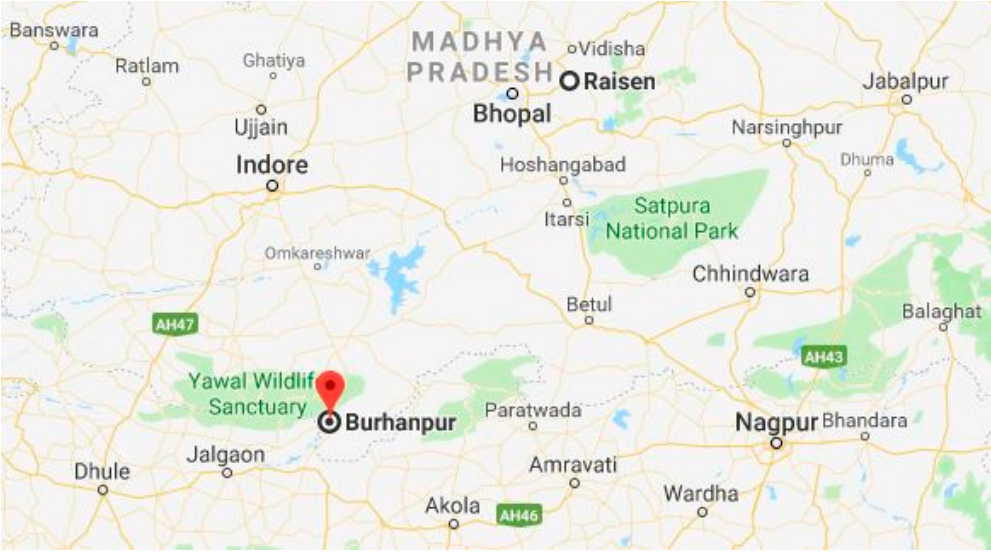
Figure 1. Map of the case study locations (source: Google Maps).